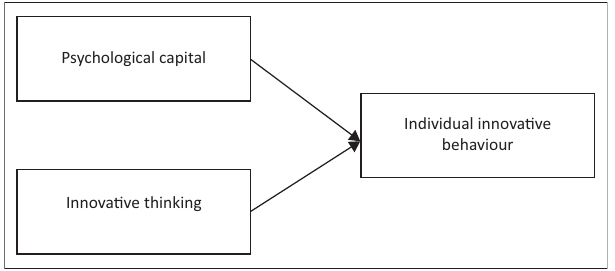
FIGURE 1: Psychological capital, innovative thinking and individual innovative behaviour